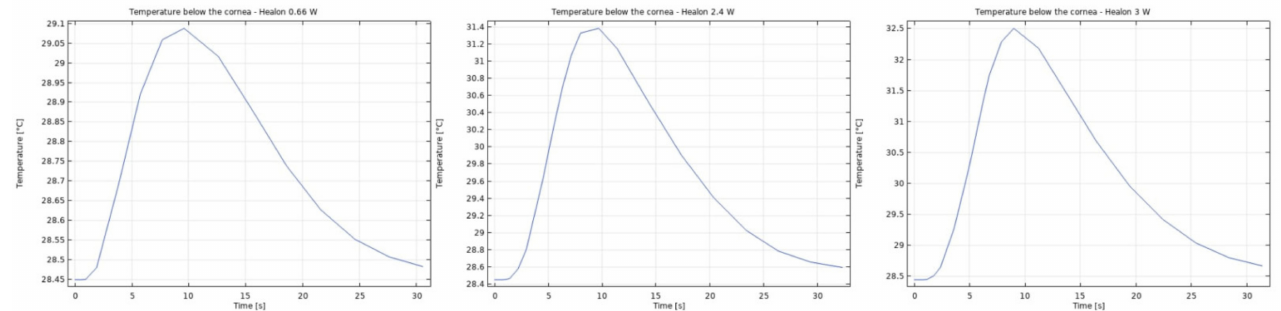
Figure 11. Temperature at the point probe with Healon after 5 s of 0.66 W, 2.4 W and 3 W